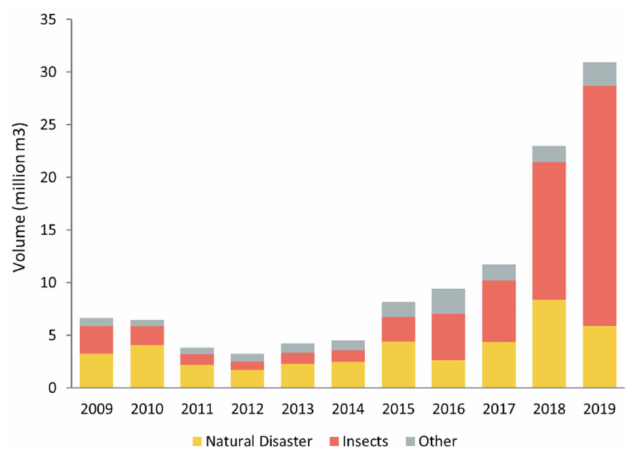
Figure 4. Progress of the volume of salvage cutting grouped by cause. Source: Ministry of Agriculture of the Czech Republic, 2020 [31].